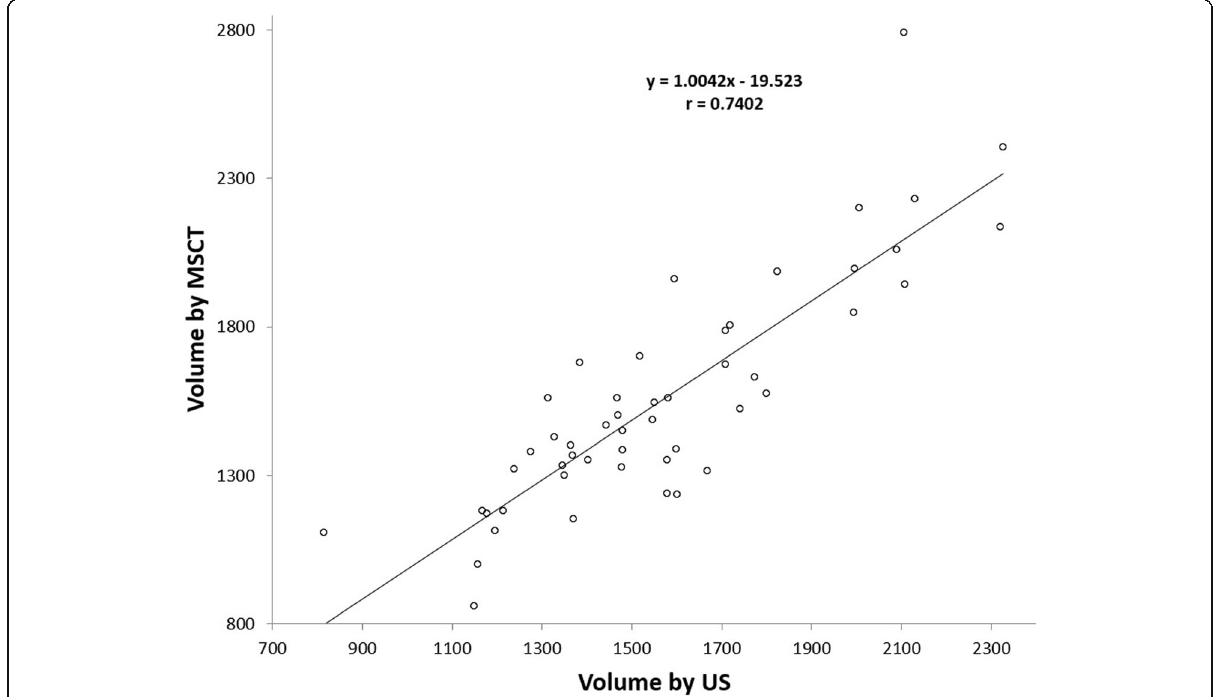
Fig. 4 Scatter plot diagram is showing correlation coefficient between US and semi-automated CT volumetry with strong positive correlation